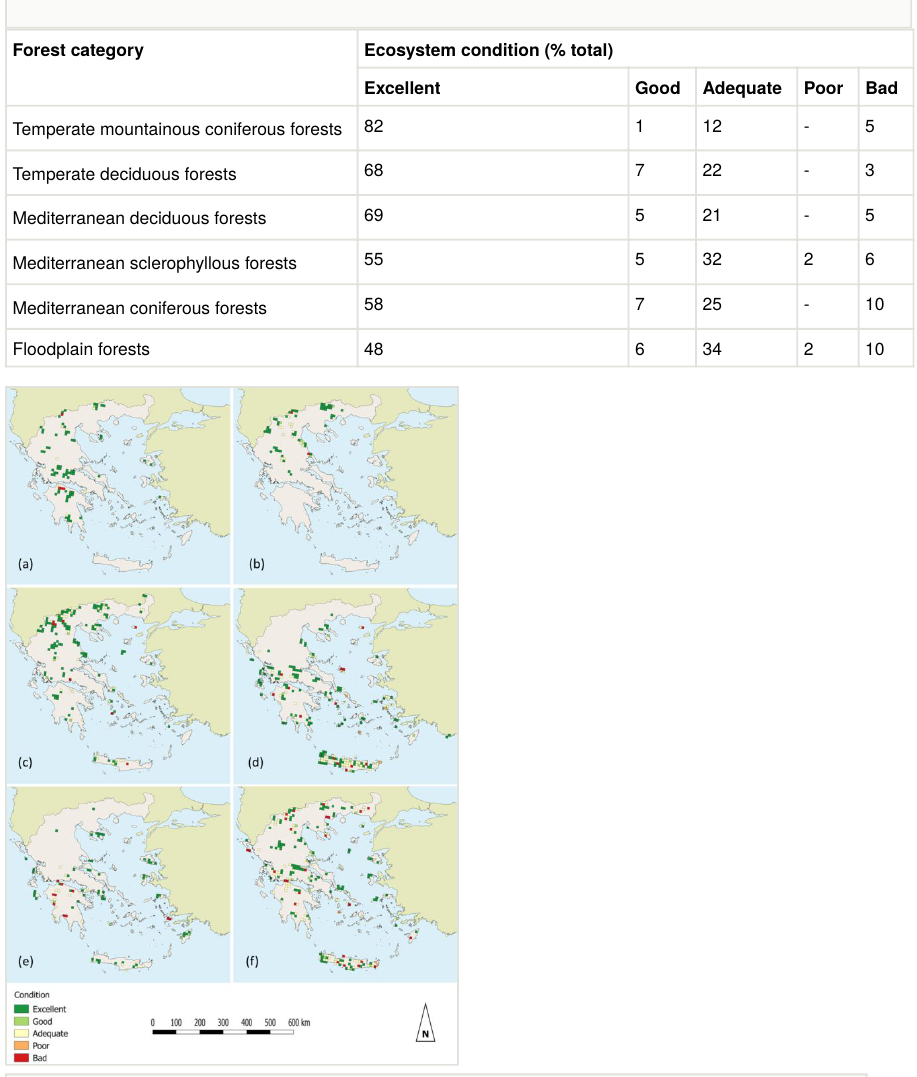
Proportion (%) of the di ff erent ecosystem condition categories assigned to the Woodland and Forest Ecosystem category (MAES level 2) in Greece, based on the EEA 10 km grid cell analysis. The ecosystem condition is scaled as: Excellent, Good, Adequate, Poor and Bad.